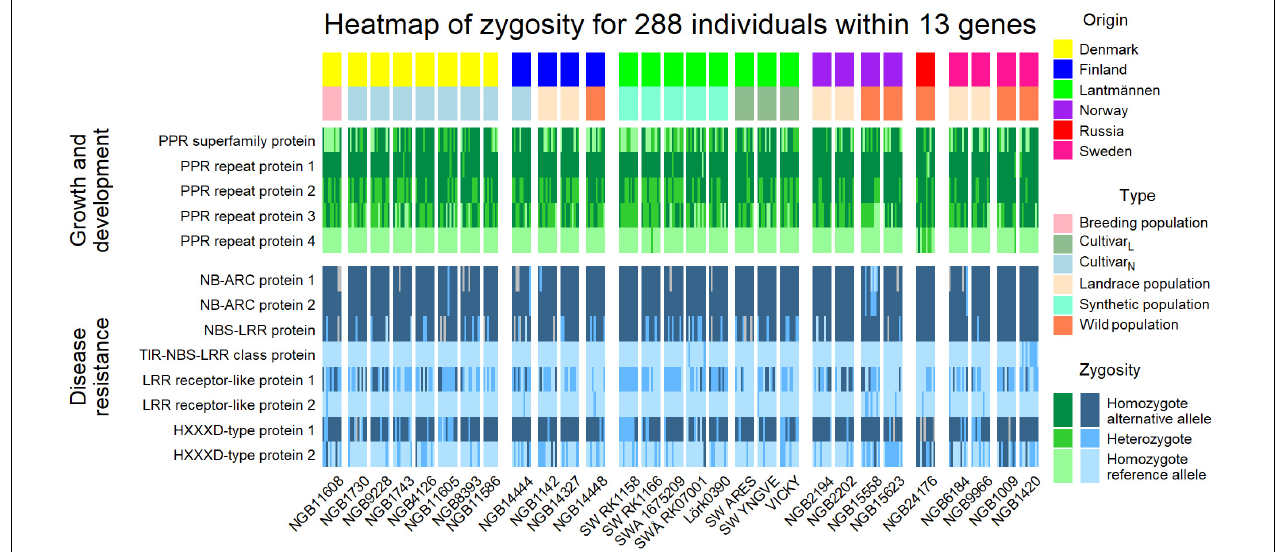
FIGURE 8 | A heatmap illustrating the zygosity level of five PPR proteins, known to play an important role in growth and development, and eight disease resistance proteins in the 288 individuals. The individuals were grouped according to their accession and the top annotation sorted the individuals further into place of origin and type. Gray fields indicate missing genotype for that individual at the particular